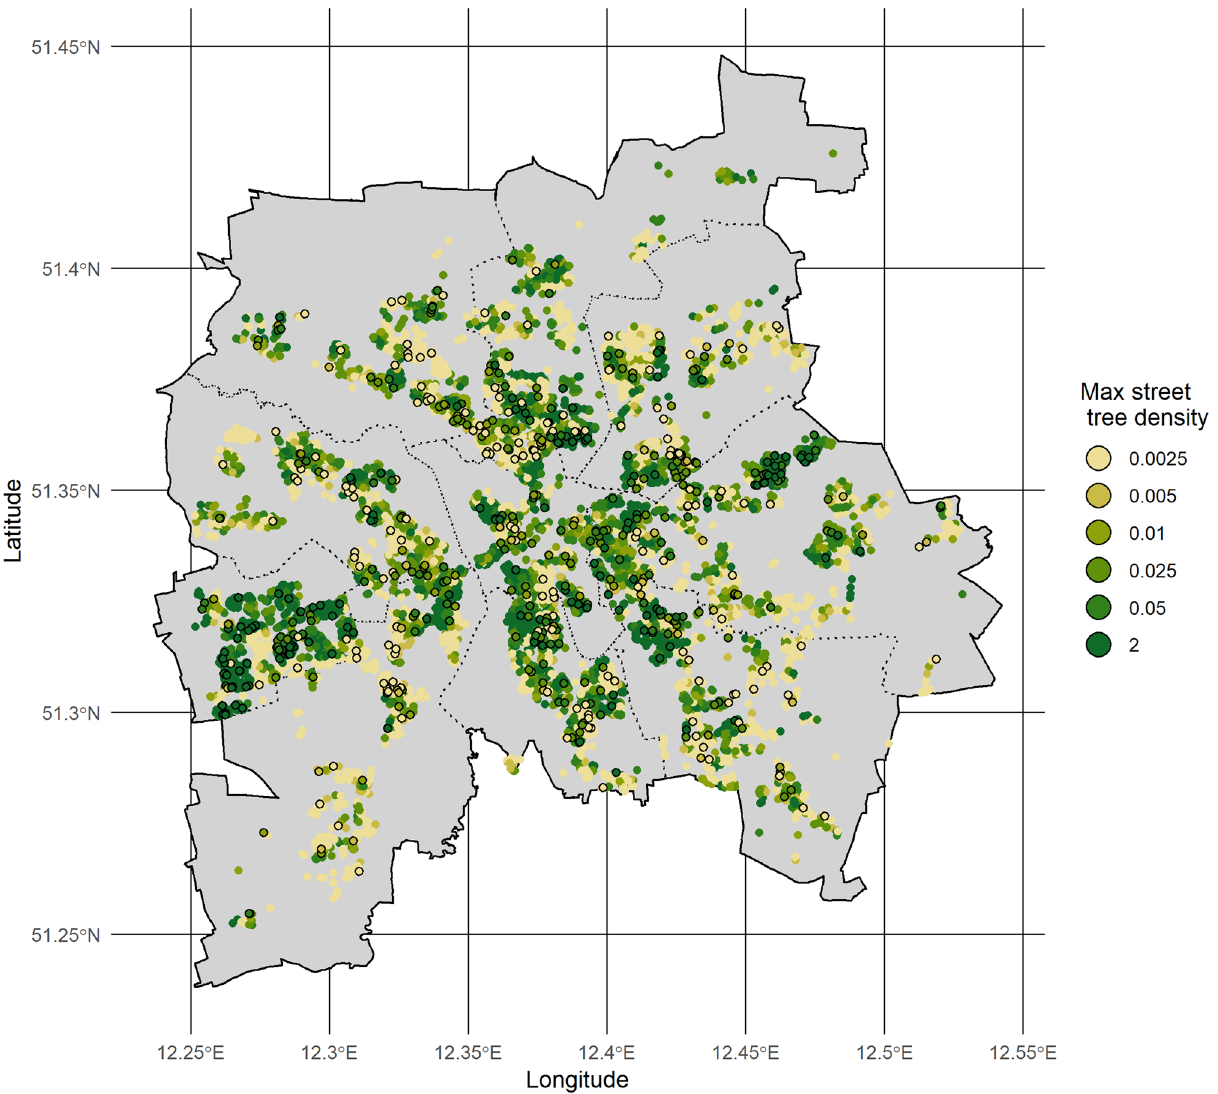
Figure 1. Distribution of street trees and antidepressant prescriptions amongst participants in the LIFE-Adult- Study. Circles indicate the location of participants within the city of Leipzig, Germany. Circles with a black outline represent individuals who have been prescribed antidepressants. Coloured circles shaded yellow-green reflect the density of street trees within 100 m of the home. Tree density values are number of trees per meter of road within 100 m buffer. The figure was created with ggplot2 49 available for R (ver. 3.5.2). It is an own creation by D. Eichenberg. Polygons for the city districts were taken from City of Leipzig, Office for Statistics and Elections; Data license Germany—Attribution—Version 2.0 50 df = 2, p = 0.14). This was due to the large uncertainty (standard error) of street trees for the high SES group (Supplementary Fig. S1). However, in the stratified analyses for each SES group, there was a significant negative effect of street tree density on antidepressants for the low SES group only (log OR = −0.21, SE = 0.08, p = 0.01). Greater density of street trees at 100 m reduced the probability of someone with low SES being prescribed anti- depressants (Fig. 4a). However, for the medium and high SES groups, the effect of street tree density at 100 m from the home did not significantly change the probability of being prescribed antidepressants (medium SES: log OR = −0.02, SE = 0.06, p = 0.72; high SES: log OR = −0.10, SE = 0.12, p = 0.44). (Fig. 4a). The net result of these differences is that under low street tree density, individuals with low SES tended to have higher probabilities of antidepressant prescriptions (Fig. 4b), but under high street tree density, individuals with low SES tended to have similar probability of being prescribed antidepressants as individuals with high SES. In other words, differences in the probability of being prescribed antidepressants between those with lowest and highest SES fell as street tree density improved. For gender and employment status, there was no significant interaction and estimated effect sizes were similar for each group in the stratified analyses (i.e., for males and females, and employed and unemployed) (Supplementary Table S6).